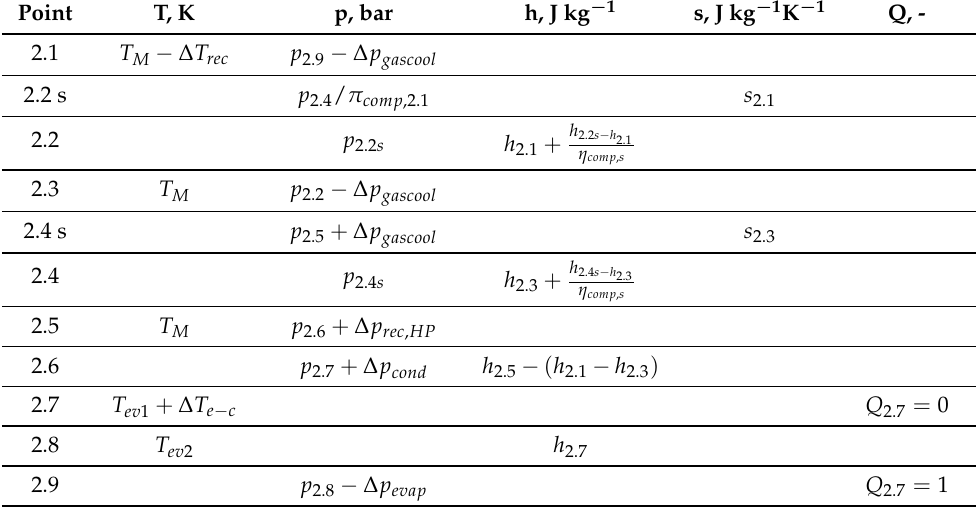
Table 3. The modeling of thermodynamic state in system characteristic points.